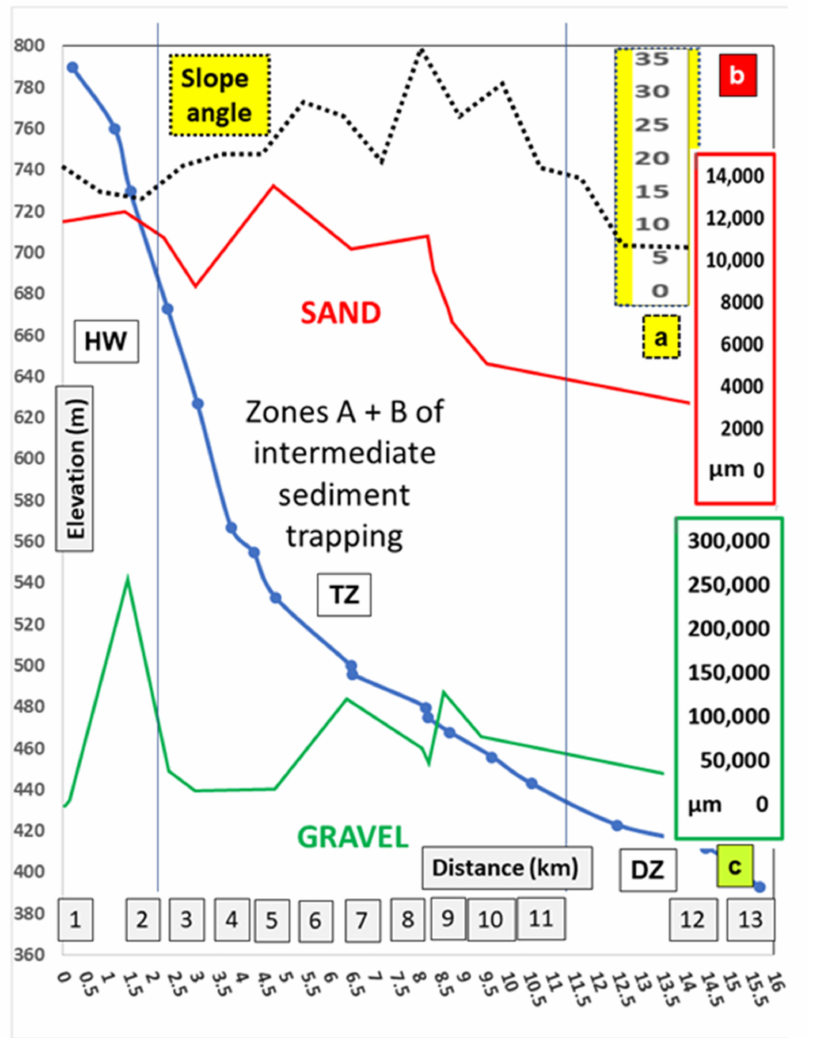
Figure 14. Grain size mean values ( µ m) as a function of slope angle and distance to source. ( a ) Yellow pattern: slope angle in degrees (between 5 ◦ and 35 ◦ ) as a function of the distance to source. ( b ) Red pattern: variation of the mean value of sand as a function of the distance to source and in relation to the slope angle (black-stippled line in degree. ( c ) Green pattern: variation of the mean values of the gravel as a function of the distance to source and in relation to the slope angle (black-stippled line in degree). HW: headwaters; TZ: transport zone; DZ: deposition zone. See also Figure 5 for